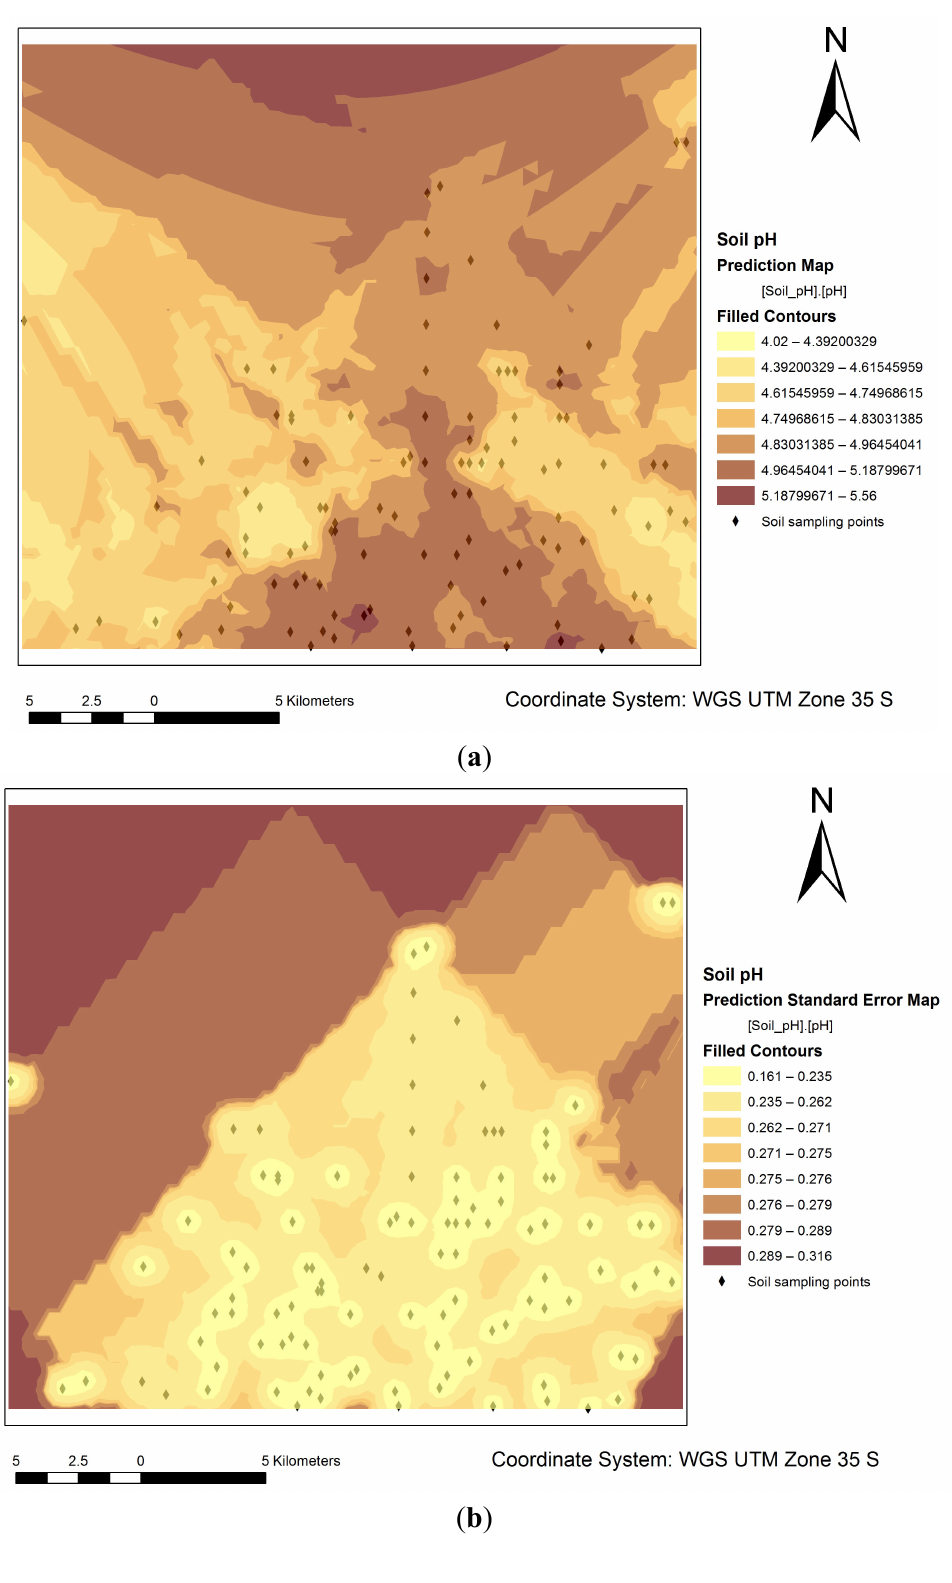
Figure 2. ( a ) Predicted soil pH map ( b ) Prediction standard error (soil